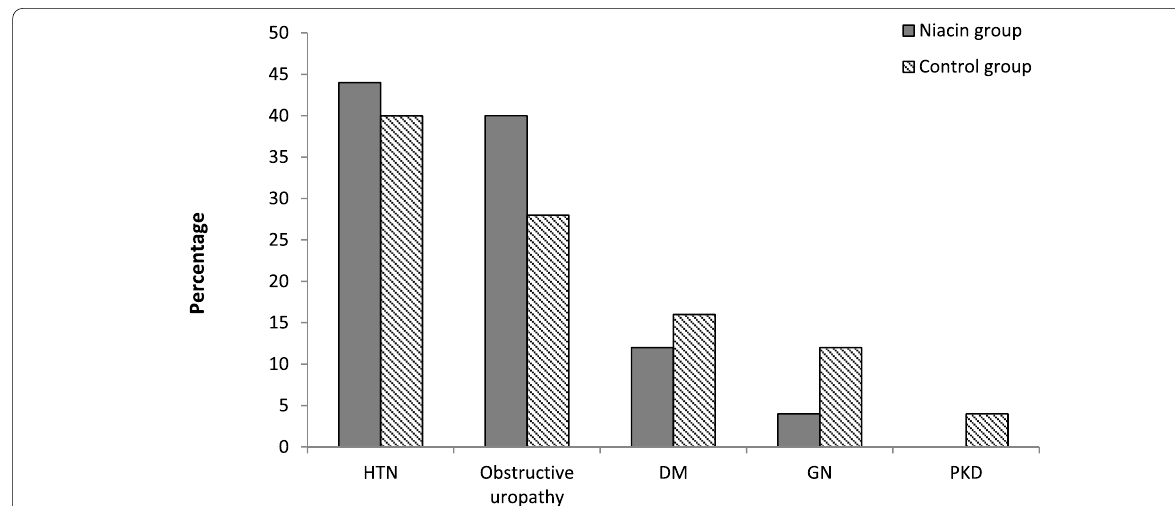
Fig. 2 Aetiology of kidney disease among the studied groups